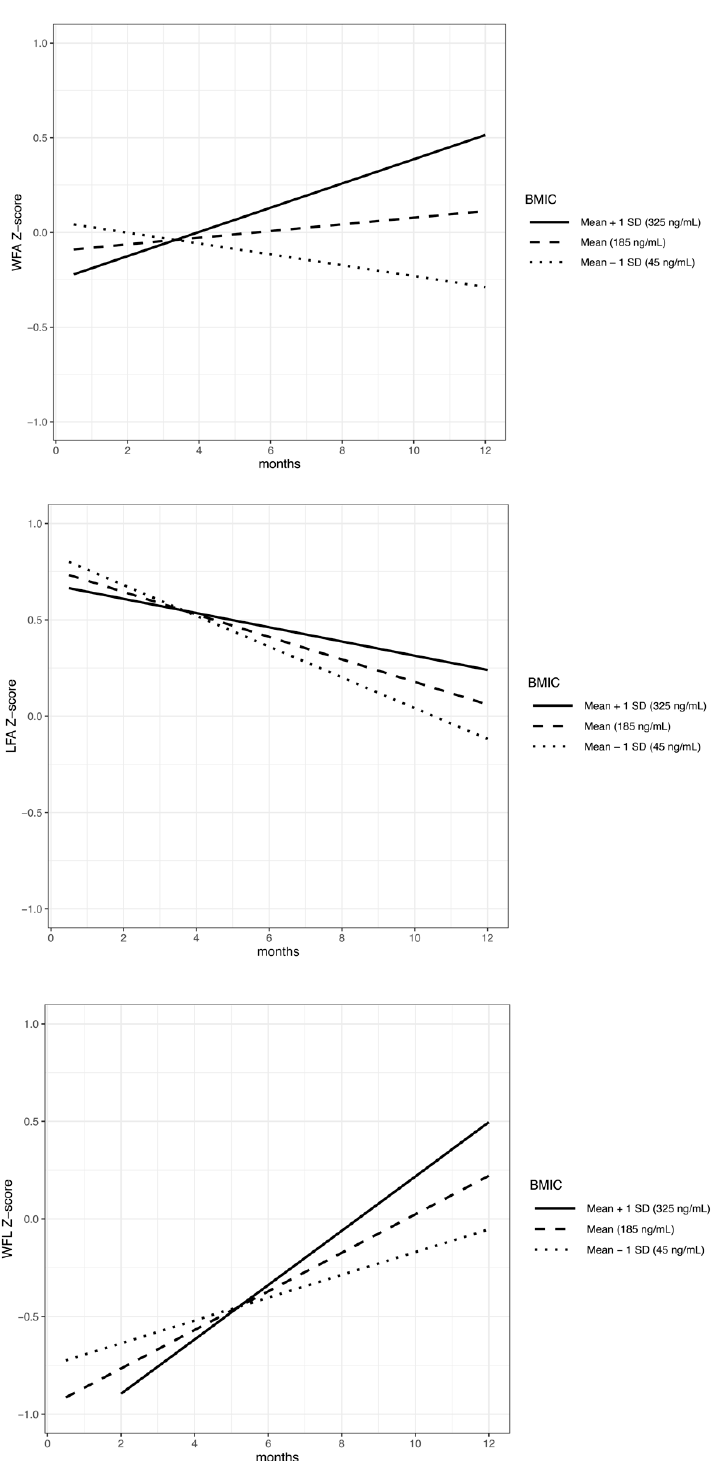
Figure 2. Infant growth anthropometric Z-score from 2 weeks to 1 year, with BMIC predicted by linear mixed models (model n = 35). Graphs depict the di ff erence in the predicted growth lines for the mean ± 1 standard deviation BMIC as measured at 2 weeks for dyads with a male infant, the mean birth anthropometric Z-score, and the mean maternal BMI. Interaction e ff ect of BMIC and time (months) on infant WFA ( β = 0.00033, p < 0.001), infant LFA ( β = 0.00015, p = 0.154), and infant WFL ( β = 0.00029, p = 0.021). Abbreviations: weight-for-age Z-score (WFA), length-for-age Z-score (LFA), and weight-for-length Z-score (WFL); breast milk iodine concentration